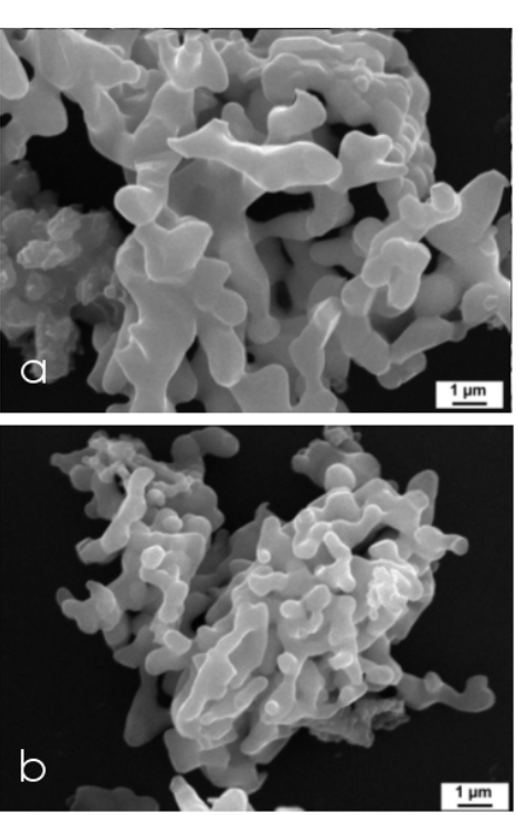
Figure 7. SEM micrographs of HA samples synthesized at 1000 o C from the sol prepared at (a) pH ~8.0 and (b) pH ~10.0. Magnification 1000X.